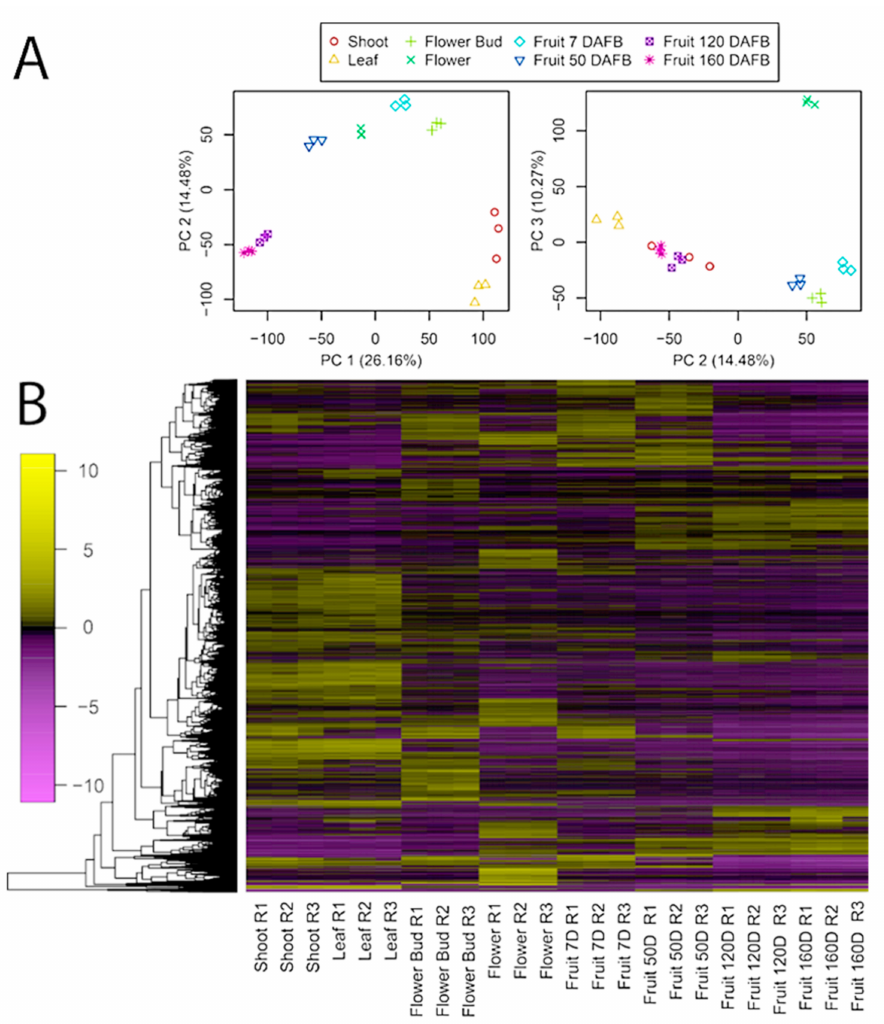
Figure 2. ( A ) Principal component analysis (PCA) of the four development stages of the study and its biological replicates (R). In the Y-axis is the principal component (PC) 2 and 3 and in the X-axis is the principal component 1 and 2, respectively. ( B ) Heatmap with filters of fold change ≥ 4 and FDR 0.05 across all tissues and replicates. Y-axis represents the genes while the X-axis shows all sample tissues and replicates. The color key represents the median centered log2 TMM-normalized TPM values. Yellow indicates a high level of expression, black indicates no change in expression, and purple indicates a low level of